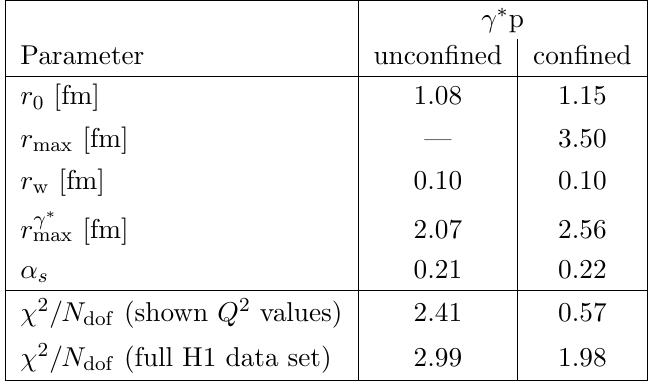
Table 3. The parameter values obtained when tuning to the (cid:27) (cid:13) (cid:3) p for the two